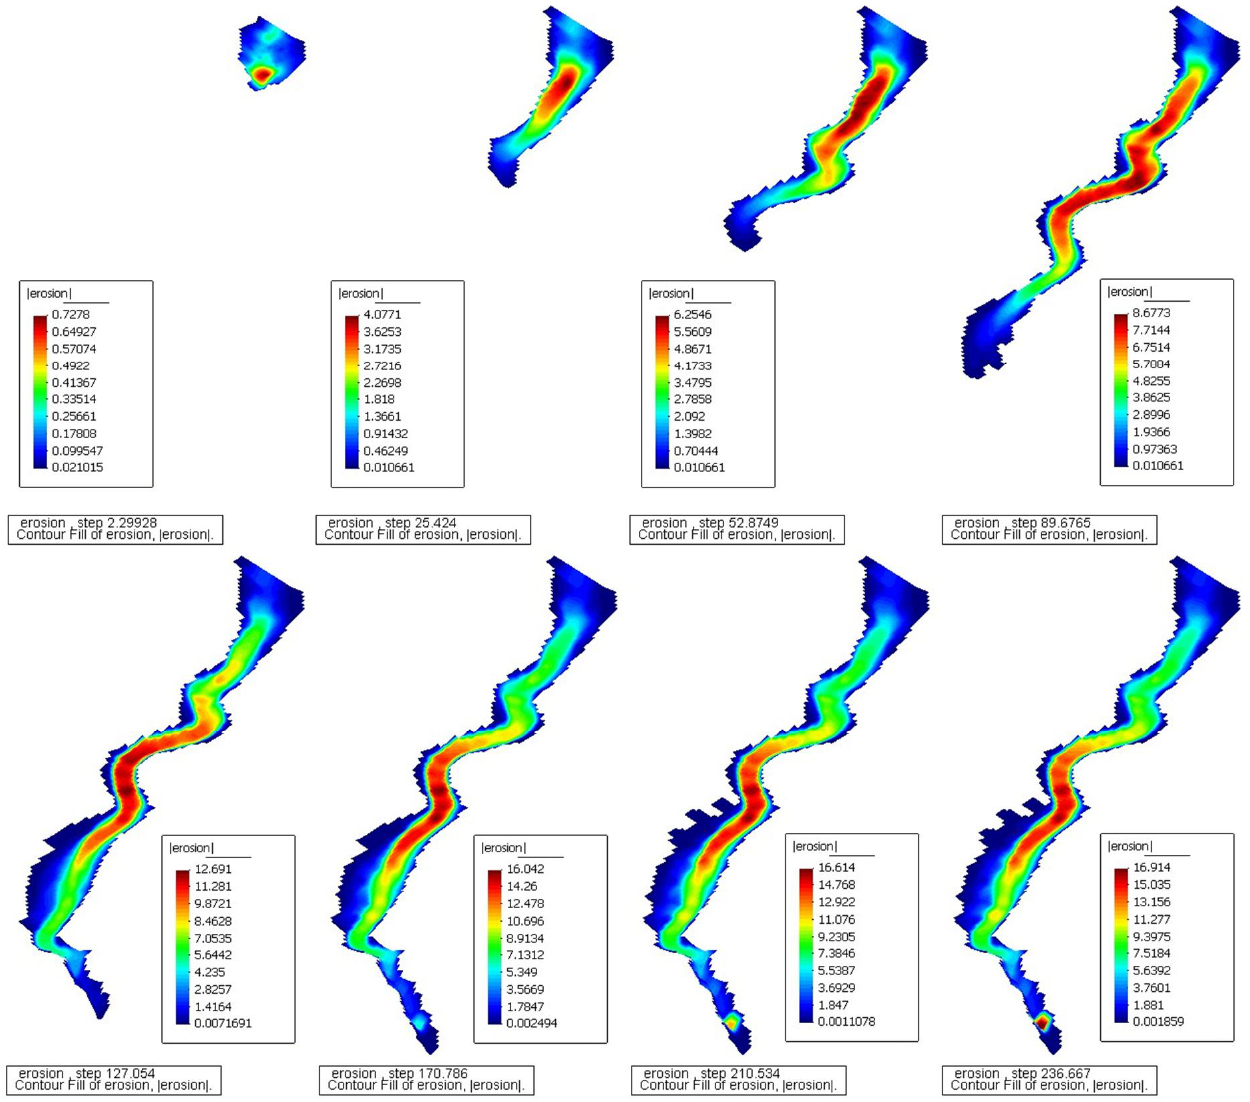
Figure 14. The simulation view of erosion activity on the Rjeˇcina watercourse with the application of the Hungr erosion law, Simulation